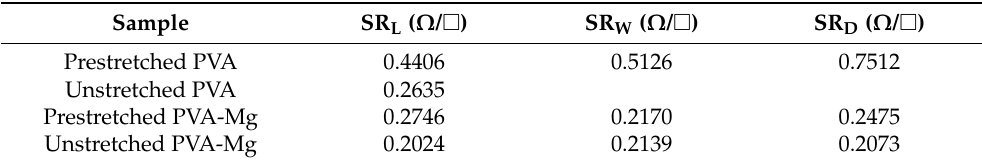
Table 3. Sheet resistance comparison between silver lines printed on unstretched and prestretched PVA and its salt-loaded derivative.